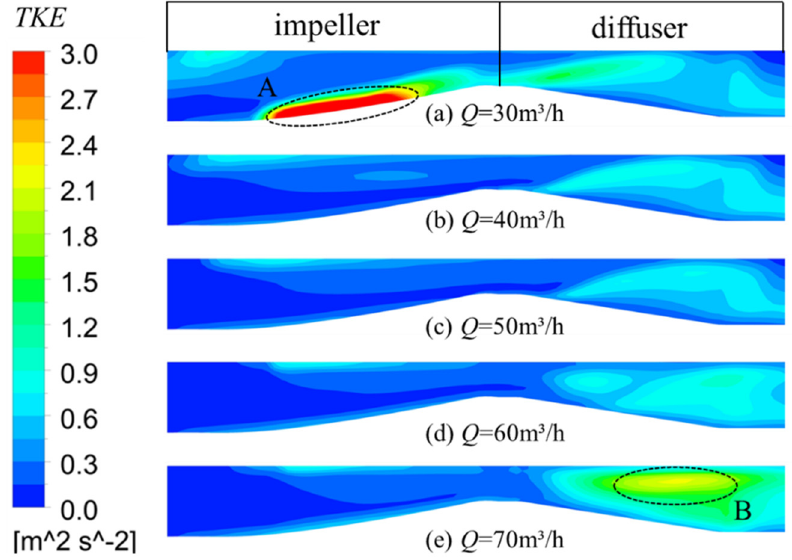
Figure 15. Distribution of turbulent kinetic energy in the impeller and diffuser under different flow conditions.